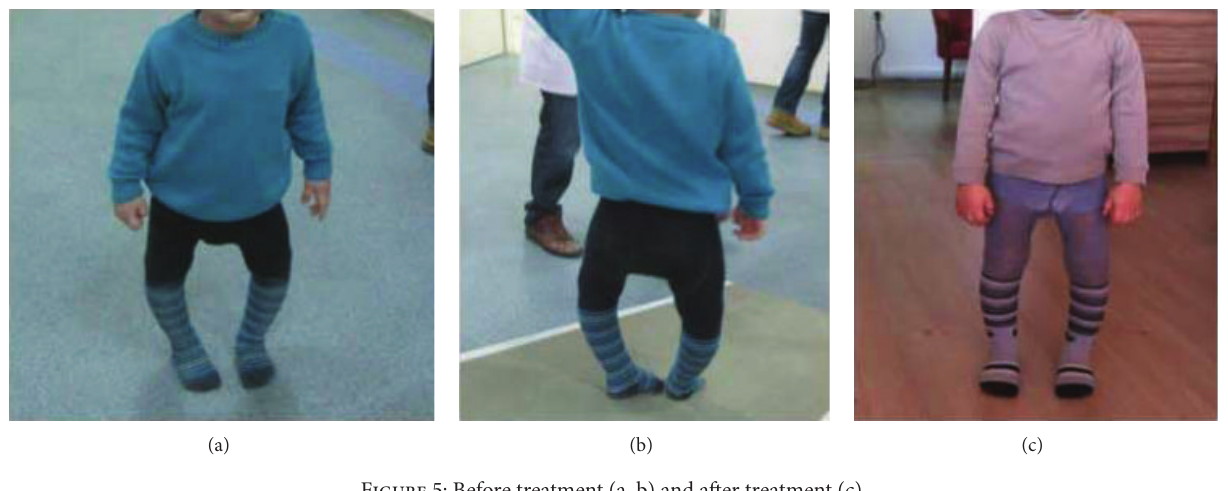
Figure 5: Before treatment (a, b) and after treatment (c). Table 1: The kinematics of the hip and knee joints total excursion degree during pre- and posttreatment in ITV.